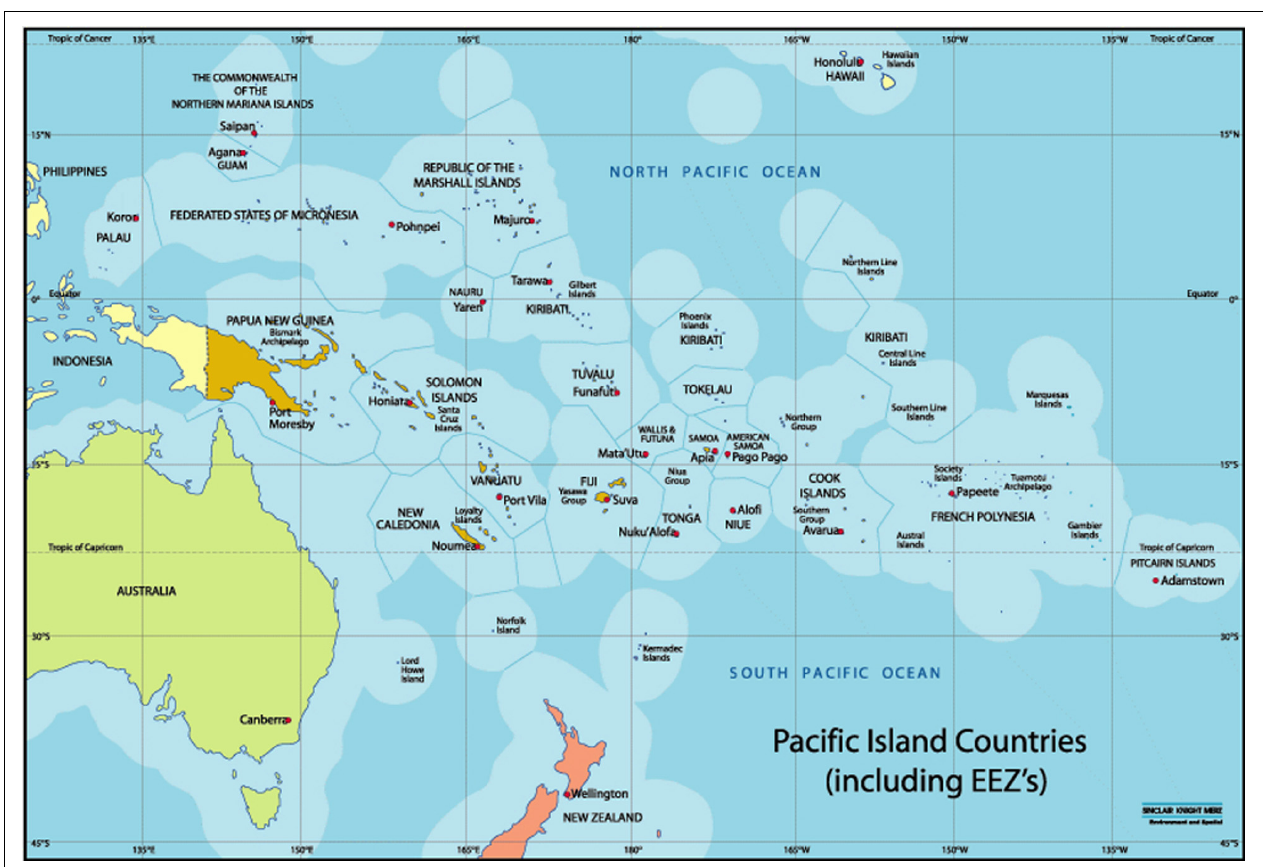
FIGURE 1 | Pacific Island region showing the Exclusive Economic Zones (EEZ’s) of the Pacific Island Countries (SPC, 2013) https://asiapacific.anu.edu.au/